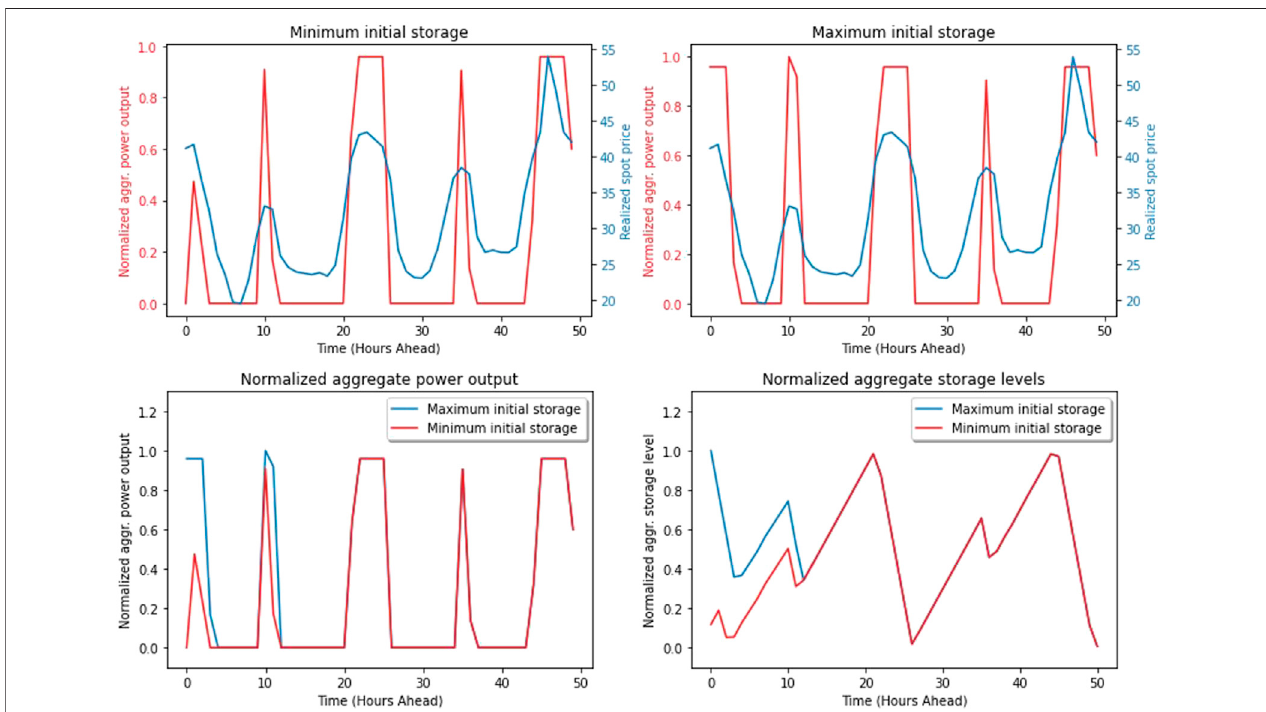
FIGURE 3 | The dependence of the total power output on forecasted prices and initial storage